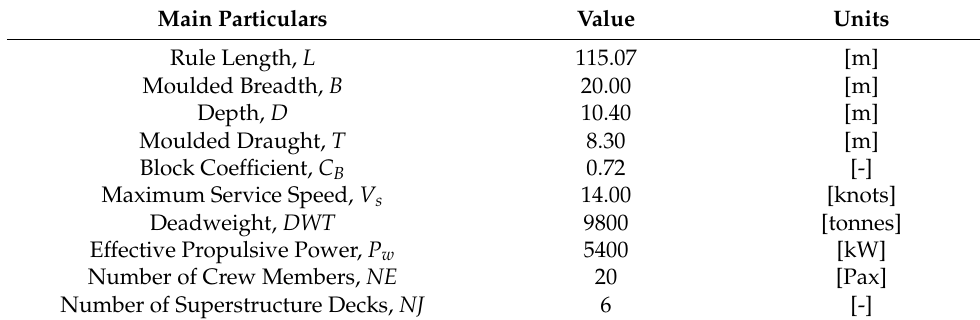
Table 1. Main Dimensions of Multi-Purpose